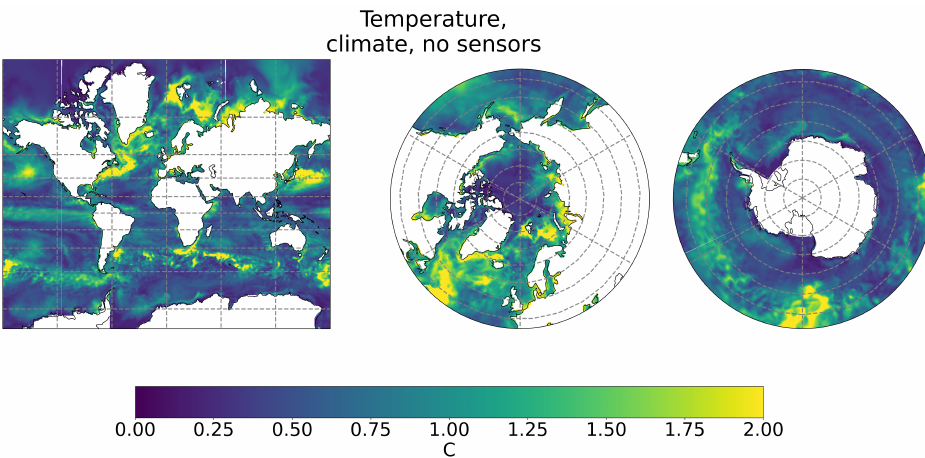
Figure 13. Spatial distribution of reconstruction RMSE by the Concrete Autoencoder (CA) from 1236 measurements.